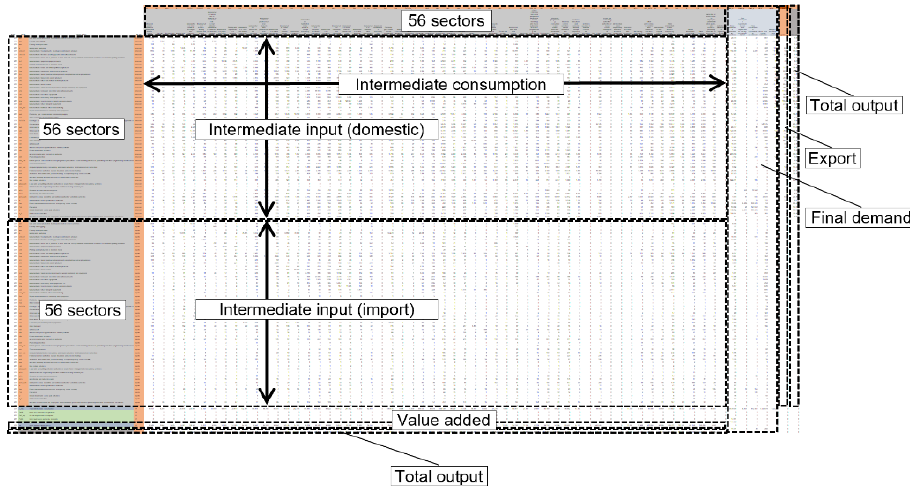
Figure 2. National input/output (IO) table (NIOT) framework. Table 1. List of sectors [3].